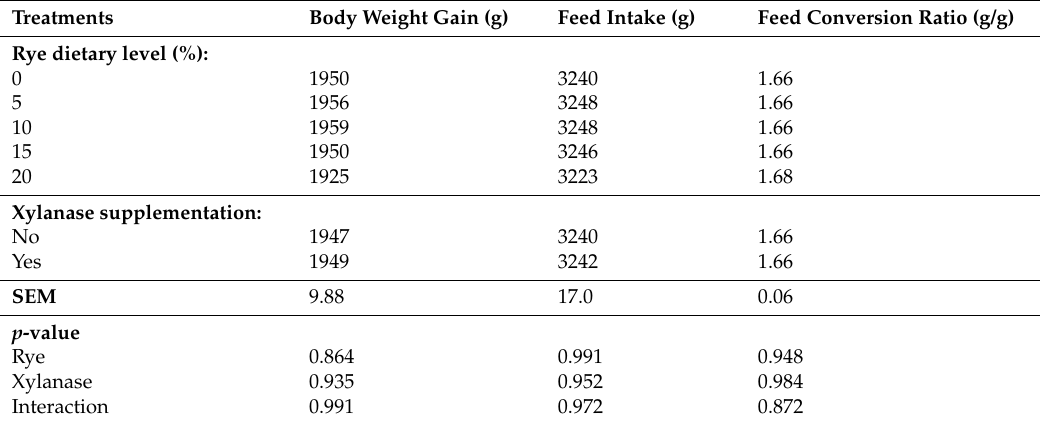
Table 4. Effects of dietary treatments on broiler performance in grower/finisher period of feeding 1 , 22–42 d of age.